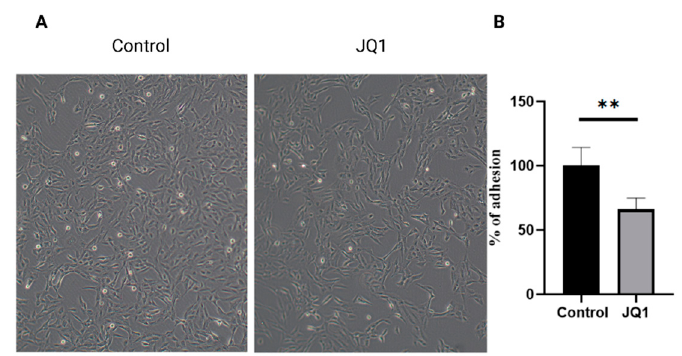
Figure 3. Adhesion of conidia from A. fumigatus , grown with or without JQ1, to human bronchial epithelial cells (BEAS-2B). Adhesion assays were performed with the conidia of A. fumigatus. DSM 790 and A. fumigatus DSM 790 treated with JQ1 100 µ M ( A ). Adhesion percent to human bronchial epithelial BEAS-2B monolayers of conidia from A. fumigatus DSM 790 and A. fumigatus DSM 790 treated with JQ1 100 µ M ( B ). The values are reported as the mean of three experiments.